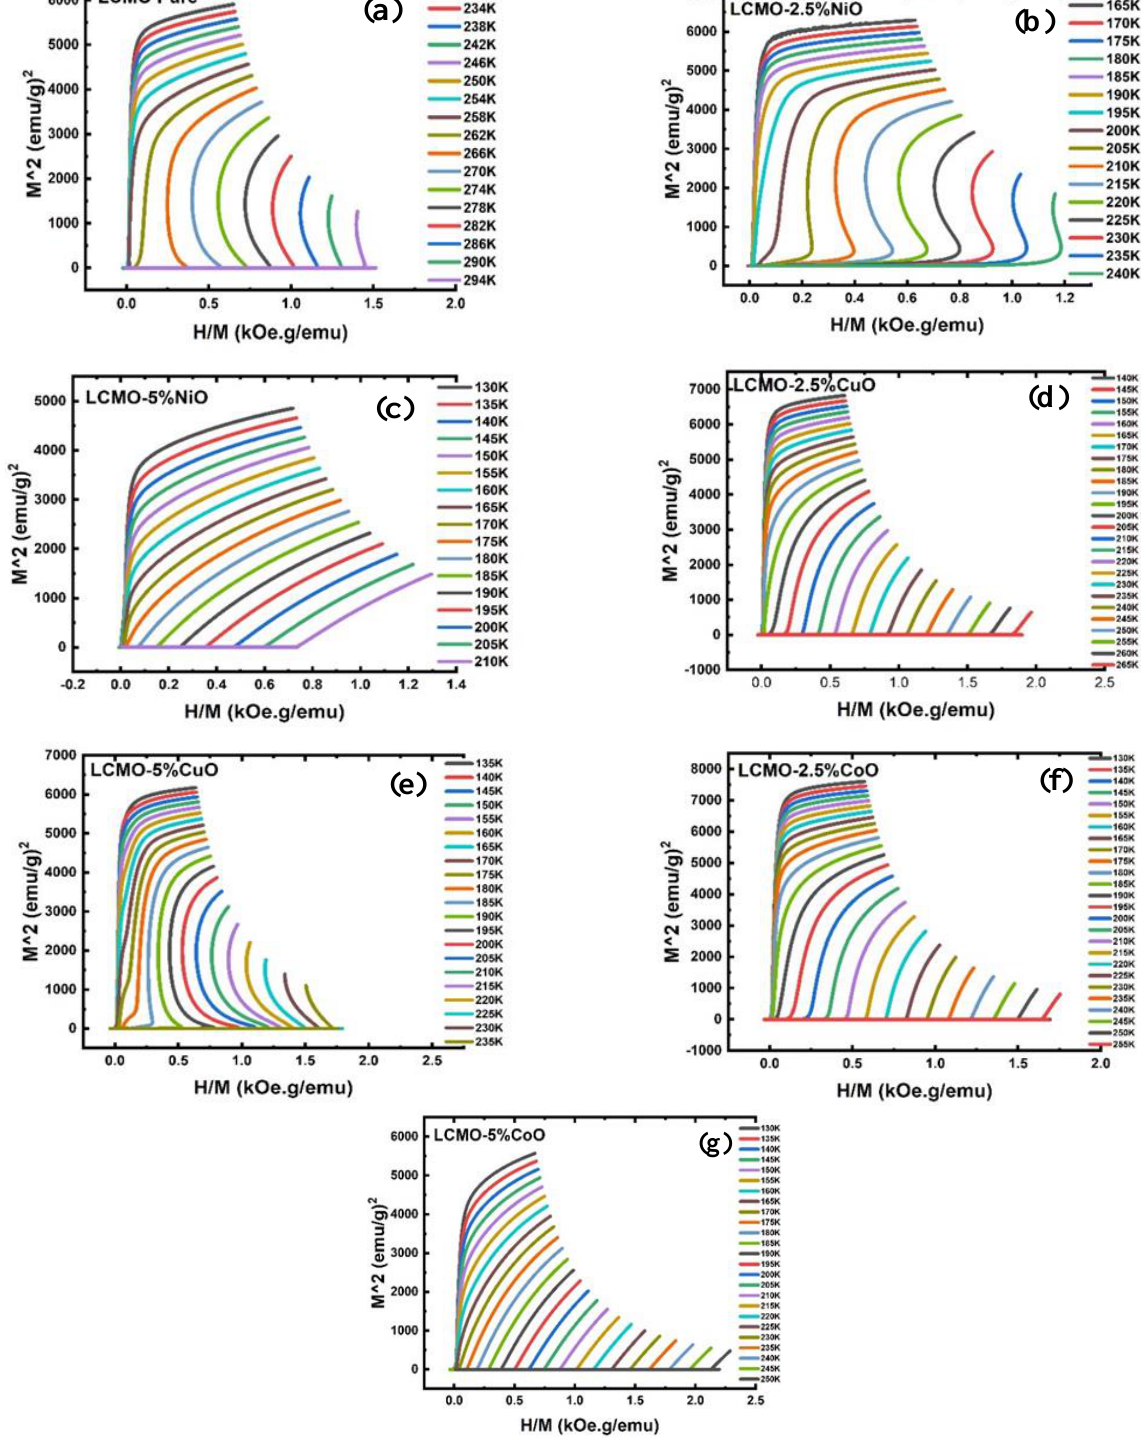
Figure 6. Arrott plots for LCMO–MO composite samples ( a ) LCMO-pure, ( b ) LMCO- 2.5 % NiO, ( c ) LMCO- 5 % NiO, ( d ) LCMO- 2.5 % CuO, ( e ) LCMO- 5 % CuO, and ( f ) LCMO- 2.5 %CoO, ( g ) LCMO- 5 %CoO. From M vs. H curves in Figure 5 at different temperatures, the change in magnetic